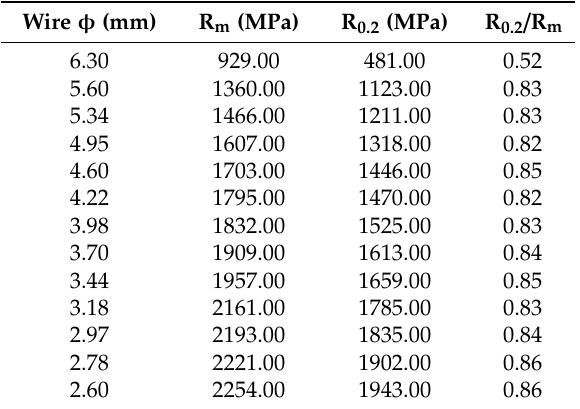
Table 6. Results of tests regarding the mechanical properties of TRIP steel wires drawn as per variant C (V c = 6.0 m / s, low single drawing reductions).